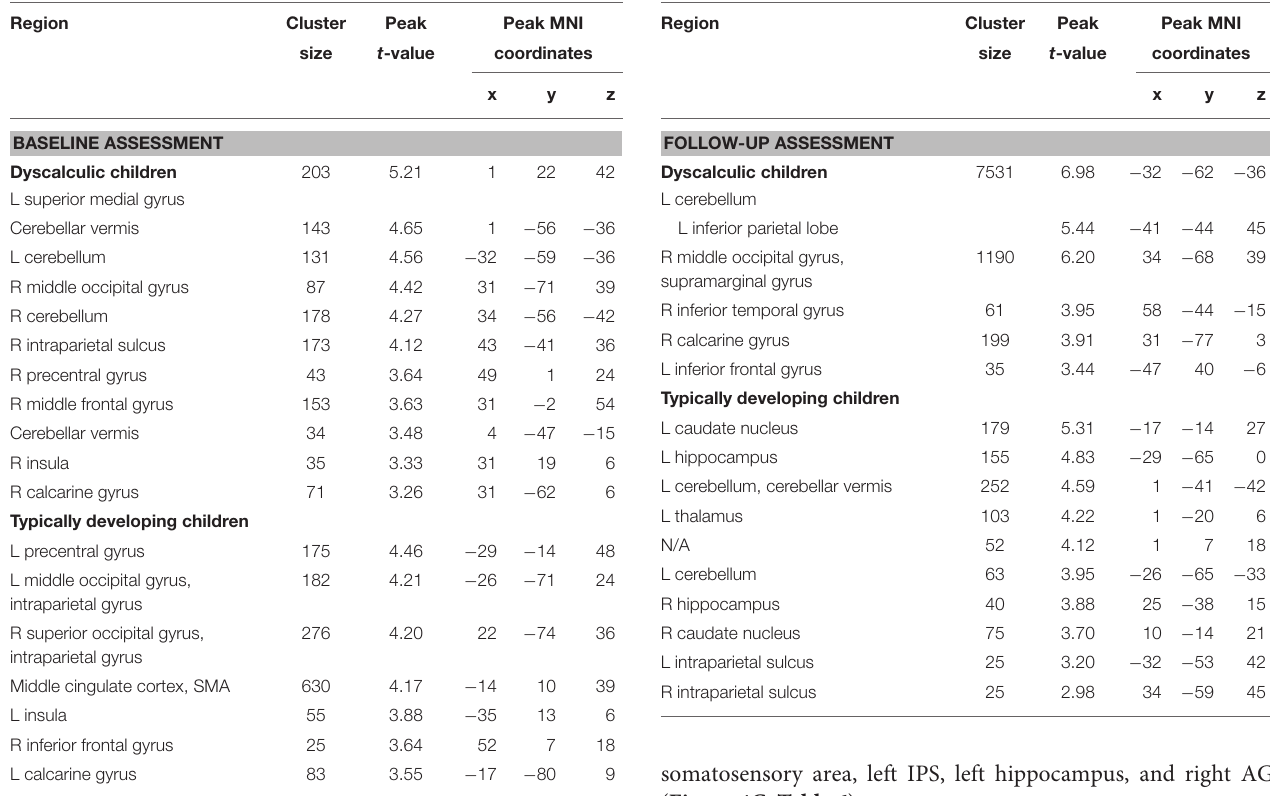
TABLE 4 | Brain areas that showed significant activation for the numerical order vs. control task from dyscalculic and typically developing children at the follow-up assessment ( p < 0.01, k ≥ 24, cluster-extend